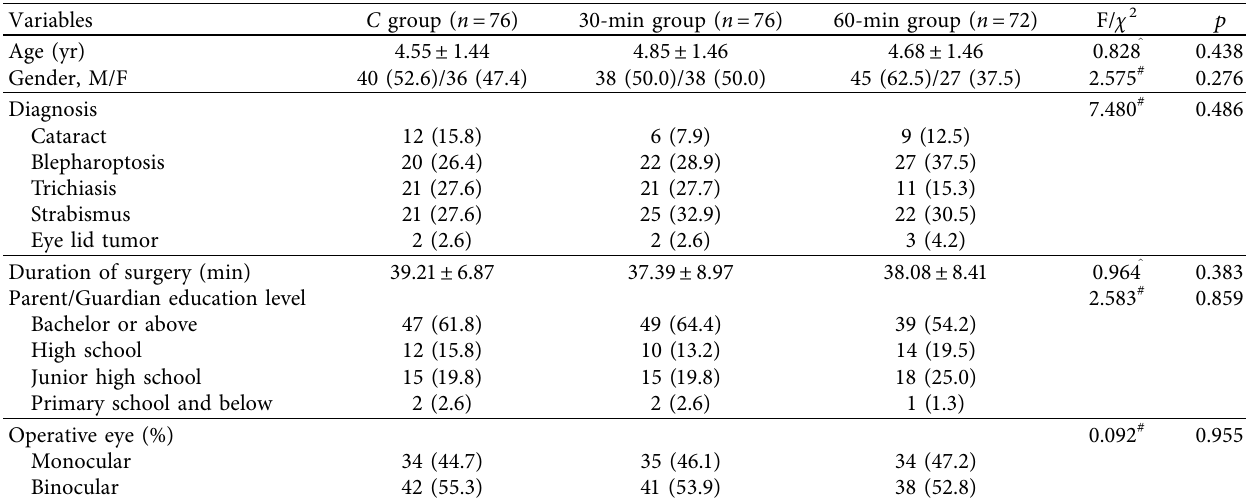
Figure 1: Flowchart of the enrollment data. Table 1: Baseline characteristics of study